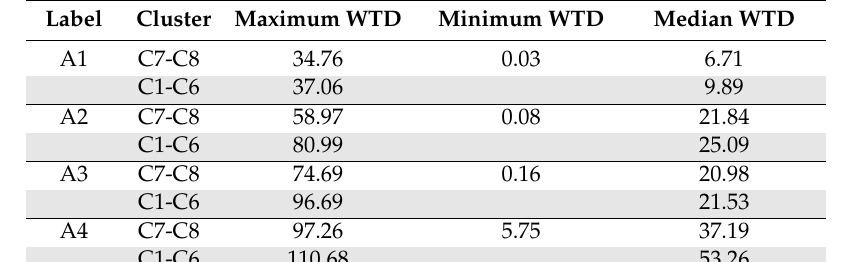
Table 6. Maximum and Minimum water table depth (WTD) in the pixels identified as C7 or C8 (white cells) and C1 to C6 (gray cells), in the areas A1, A2, A3, and A4 (shown in Figure 6).